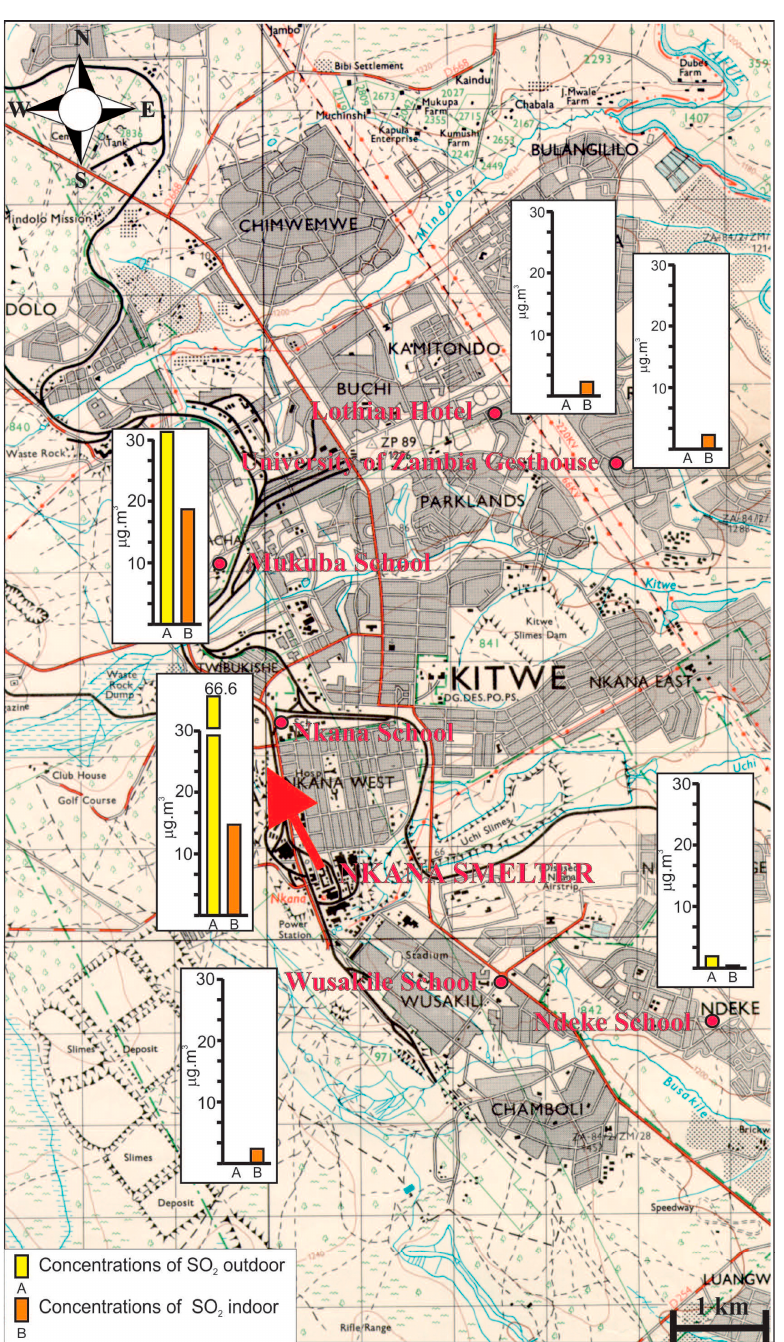
Figure 4. Concentrations of sulfur dioxide in the air in selected monitoring points in Kitwe, Zambia. Red arrow indicates the direction of prevailing dust fallout from the Nkana Smelter. After K ř íbek and Nyambe [93].